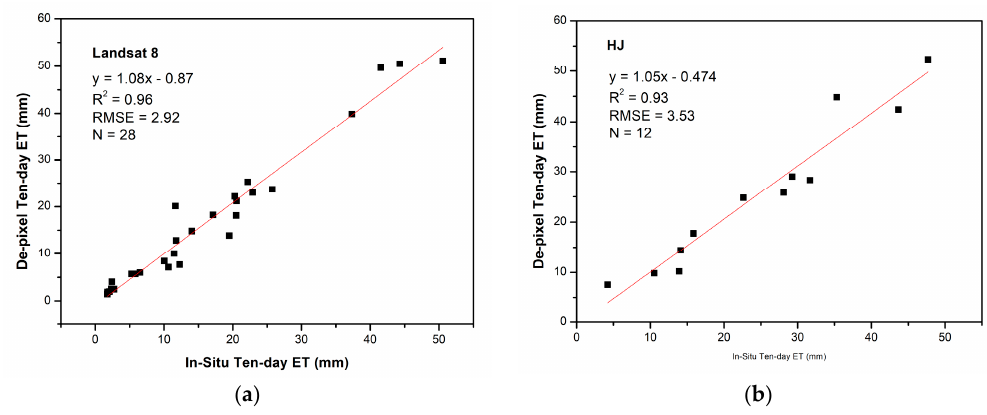
Figure 9. Comparison of ten-day downscaled 30-m ET data from the ( a ) Landsat8 and ( b ) HJ satellites with in situ observations.